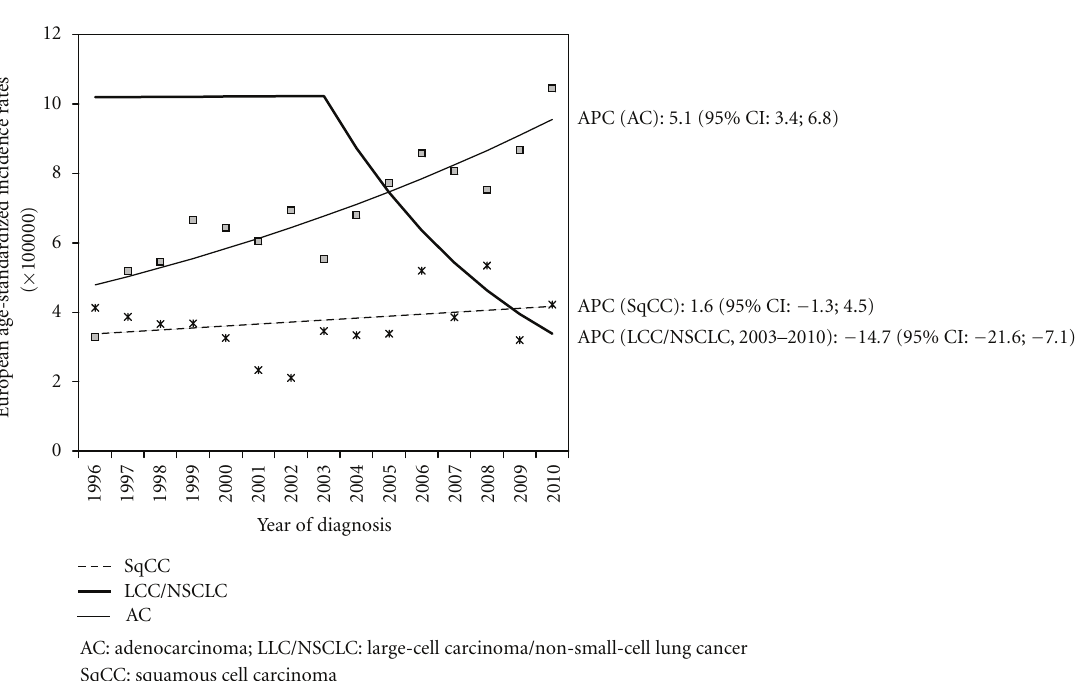
0 . 0001), corresponding to a percentage decrease of